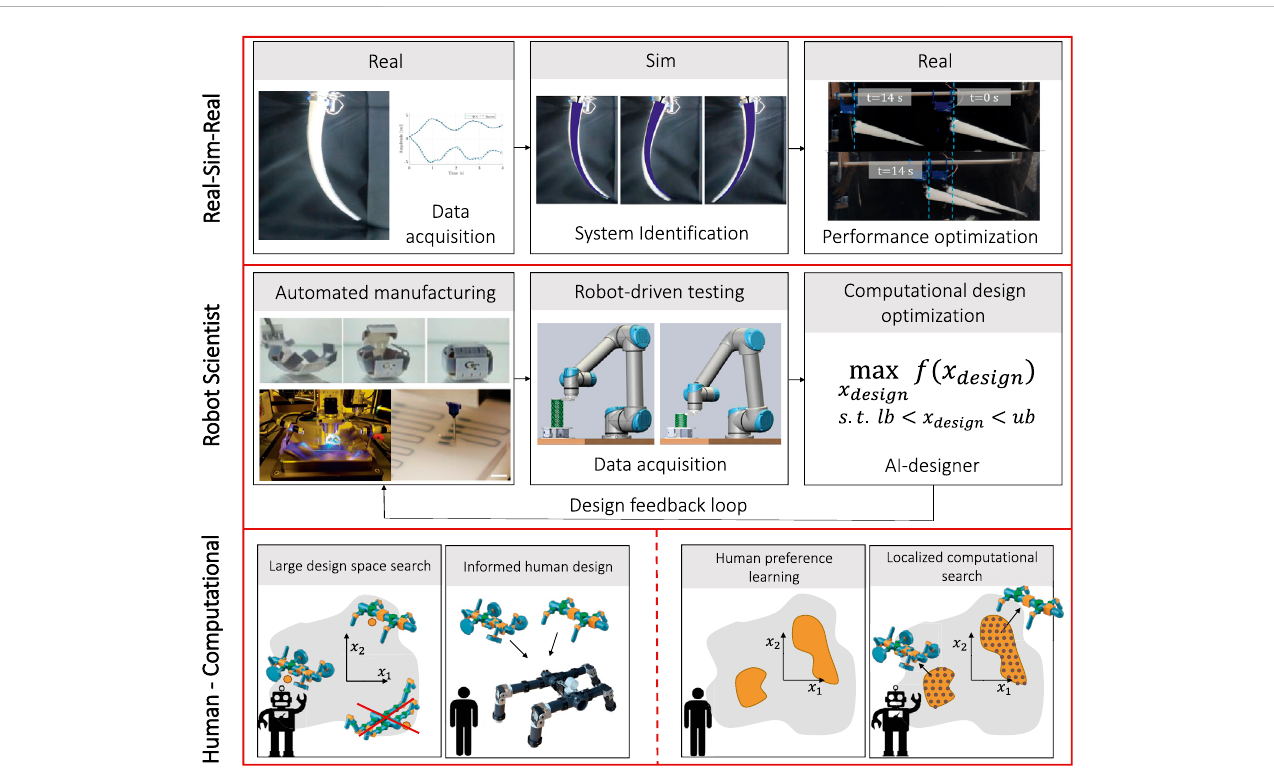
FIGURE 4 Schematic representation of the methodological advancements proposed. On the top row, fi rst an embodied setup of the system to optimize is manufactured, and data about the behavior within the environment are captured with few experiments. The simulation is then informed of the real behavior through relity to simulation regression and identi fi cation methods. Finally, in simulation the structure morphology and control strategy is optimized, and brought back to reality. Thanks to the generality ofthe learnt model, thesimulationcan beused to optimize boththemorphology and thecontrol policy of the system (Stella et al., 2022). In the middle row, the robot is automatically manufactured, thanks to multi-material 3D printing, 4D printing or other automatic manufacturing technologies. The robot is then evaluated and tested by a second robotic system — the robot scientist — which captures data about the behavior. These real-world data inform the optimization algorithm, which generates the next iteration in the design by varying the robot structure, the controlpolicy oracombinationofthetwo.Inthebottomrow,twopossiblepipelinesforhuman — computationaldesigncollaborationarehighlighted.Onthe right, a large design space spanning different morphologies and control policies is explored computationally, and the best performing robot designs are returned to the human, which can then combine the most interesting features and account for manufacturability. On the left, the human informs the computational design algorithm on interesting zones of the design space, and on these the optimization method performs a extensive search for the best